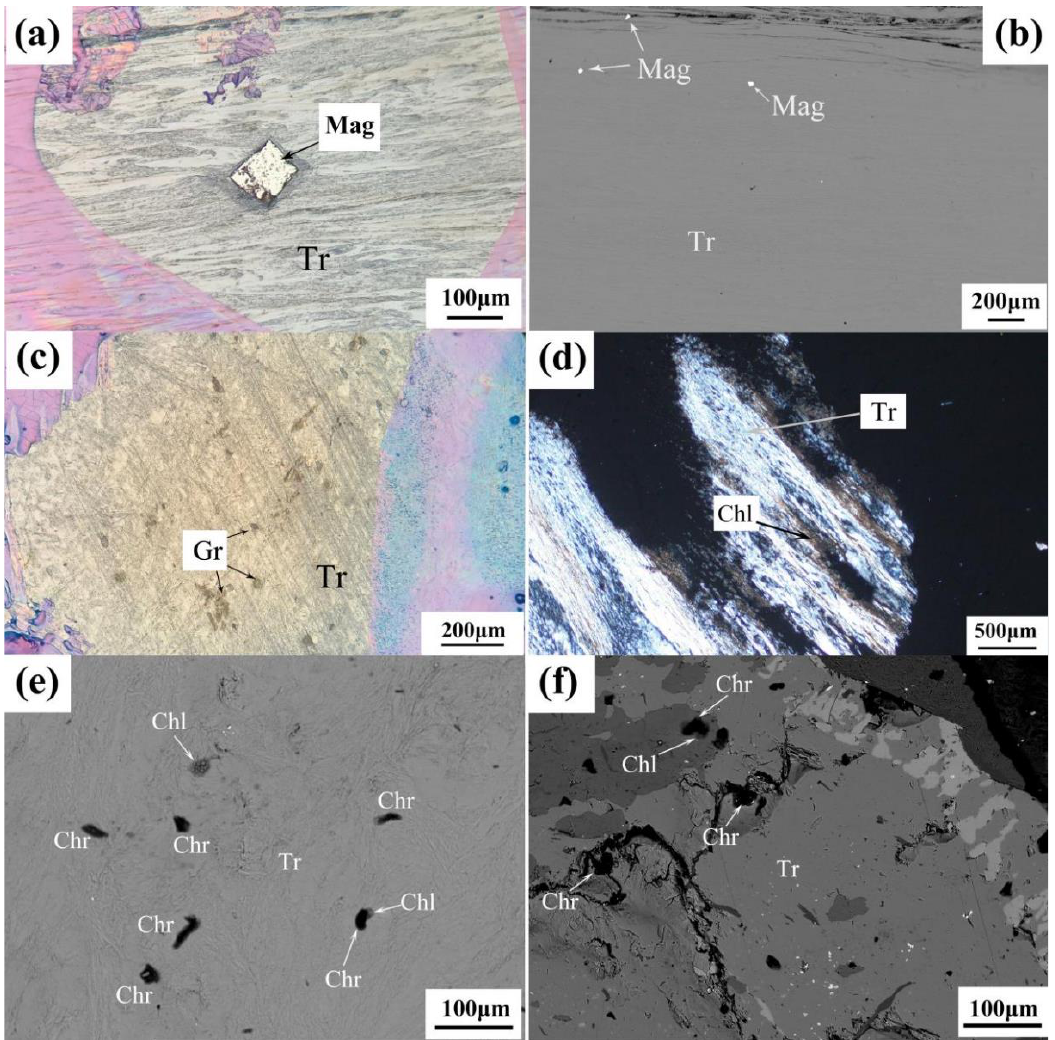
Figure 6. The secondary minerals in the sample. ( a ) Idiomorphic granular magnetite under reflected light. ( b ) Magnetite under SEM. ( c ) Altered hypidiomorphic flake graphite under reflected light. ( d ) Chlorite highly altered under cross-polarized light. ( e ) Chlorite, chromite, and chlorite coated with chromite under SEM. ( f ) Cataclastic texture of chromite under SEM. Tr: tremolite; Mag: magnetite; Gr: graphite; Chl: chlorite; Chr: chromite.